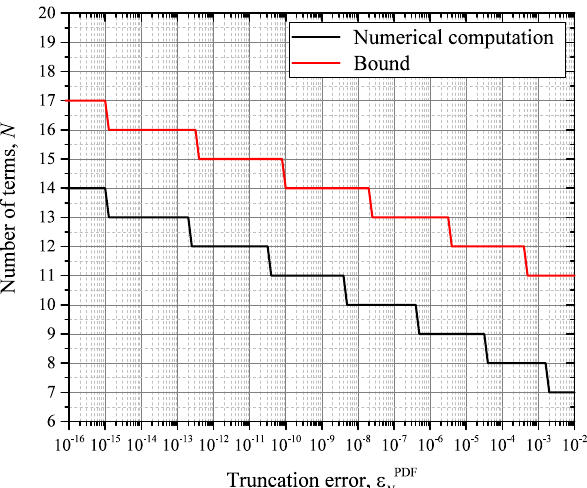
Figure 1. Required number of terms computed numerically and using the bound given by